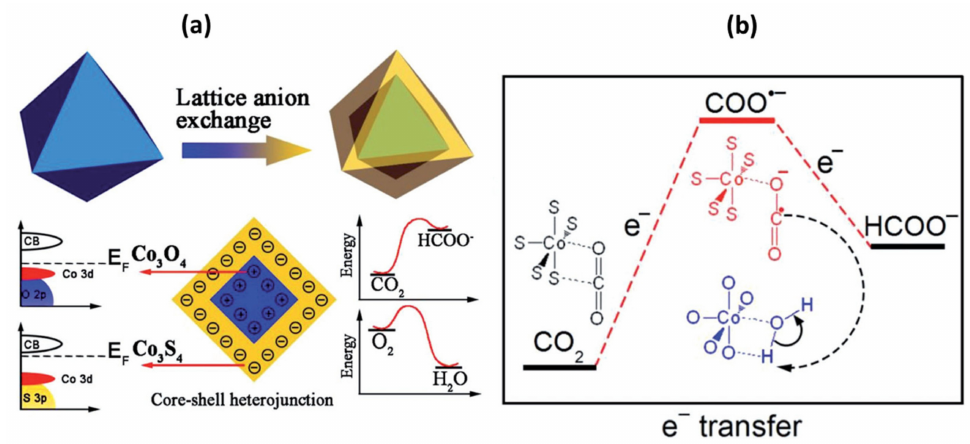
Figure 6. Scheme for the Co 3 S 4 @Co 3 O 4 core–shell electrocatalyst ( a ) and the mechanistic energy diagram for the formation of HCOO - ( b ). Reproduced from [139], with permission from WILEY- VCH,